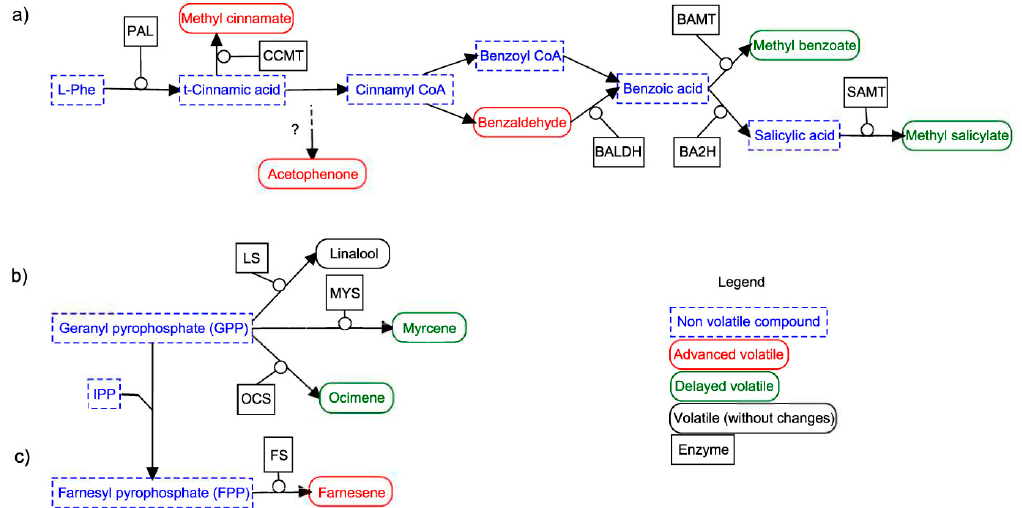
Figure 5. Schematic view of some phenylpropanoids/benzenoids ( a ), monoterpenes ( b ) and sesquiterpenes ( c ) pathway. Non-volatile compounds are represented in a dashed and blue rectangle and volatile compounds with a solid line and a rounded rectangle, the green color indicates a volatile that displays a delayed emission and the red color, an advanced emission. Enzymes and the C 5 unit IPP (isopentyl diphosphate) are shown over the arrows. Enzyme abbreviations: BA2H (benzoic acid 2-hydroxylase), BALDH (benzaldehyde dehydrogenase), BAMT (benzoic acid carboxyl methyl transferase), CCMT (cinnamic acid carboxyl methyl transferase), FS (farnesene synthase), LS (linalool synthase), MYS (myrcene synthase), OCS (ocimene synthase), PAL (phenylalanine ammonia